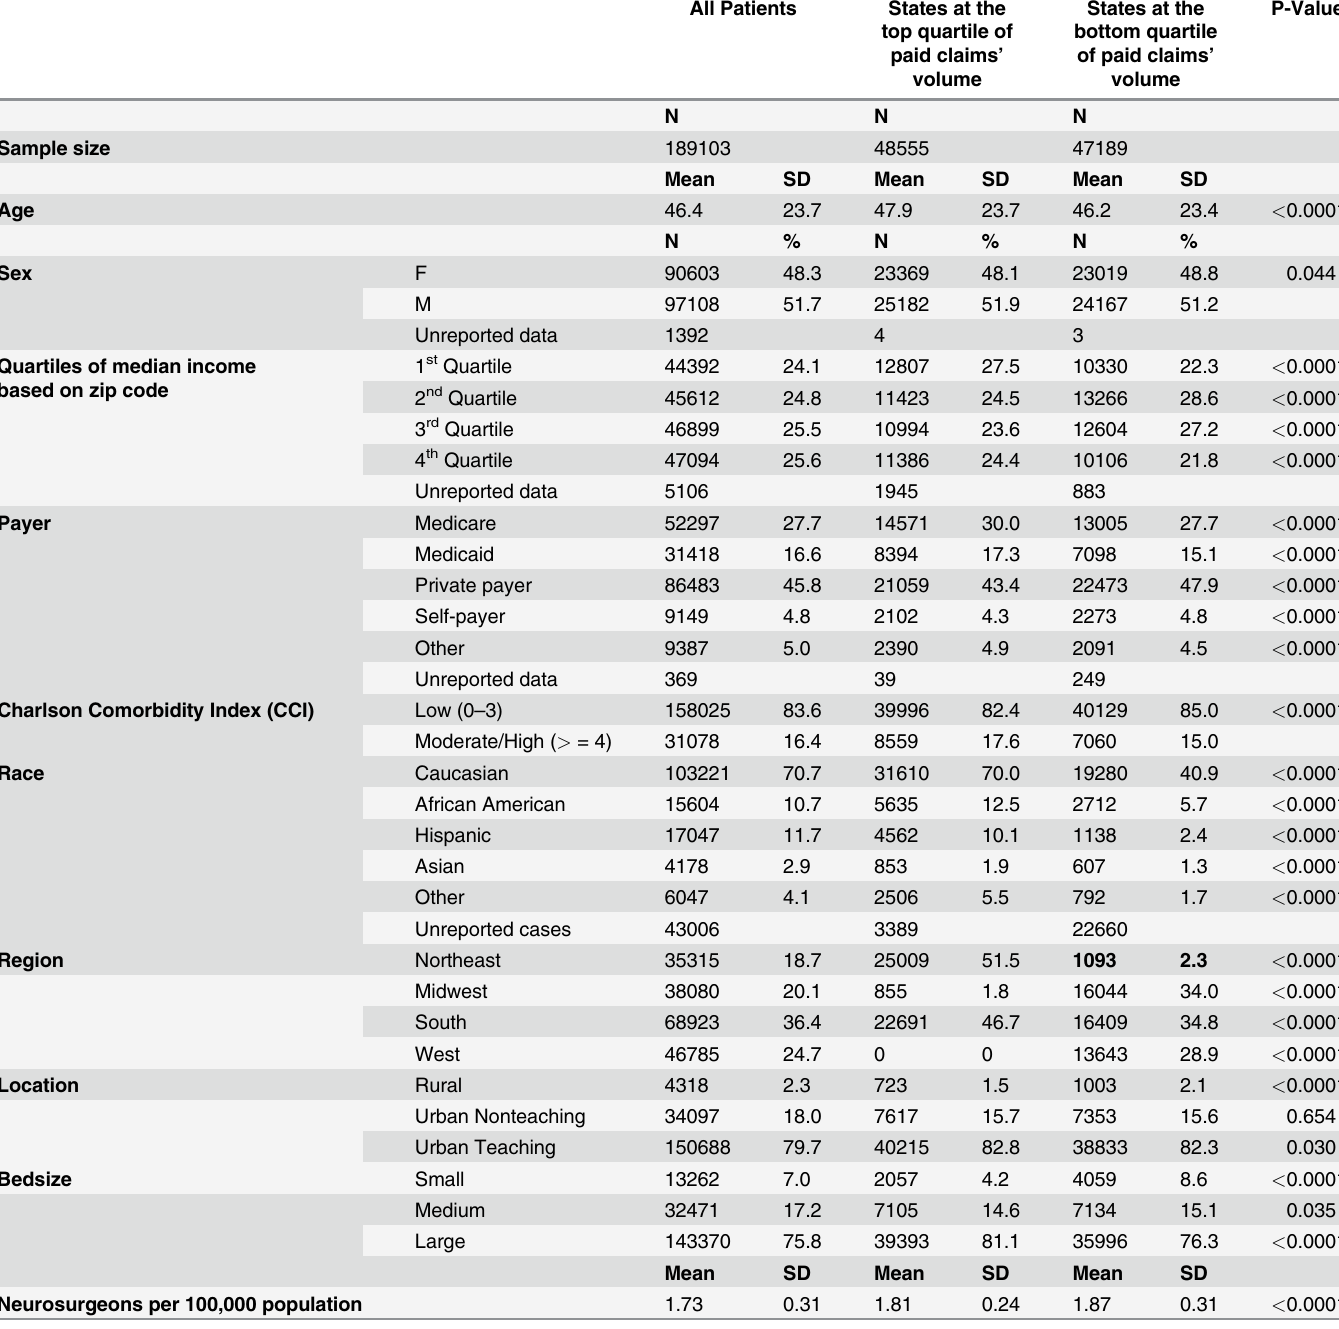
All Patients States at the